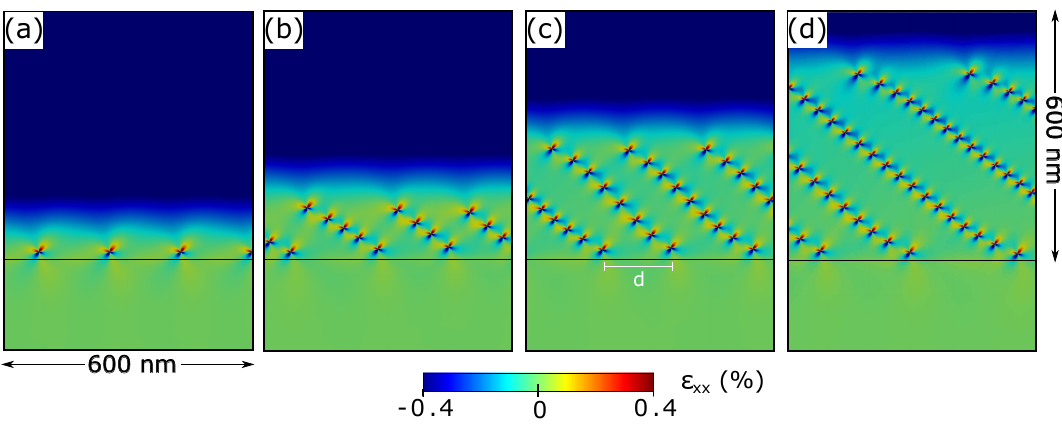
Figure 4. Effect of the dislocation number on the typical pileups shapes. Grading rate has been kept fixed at 83.3% µ m − 1 in a 1200 nm simulation cell (half of the simulation cells is shown). Film thickness is 600 nm. The number of dislocations per simulation cells are 7 ( a ), 28 ( b ), 56 ( c ), and 90 ( d ). Colormaps show ε xx component of the strain field.